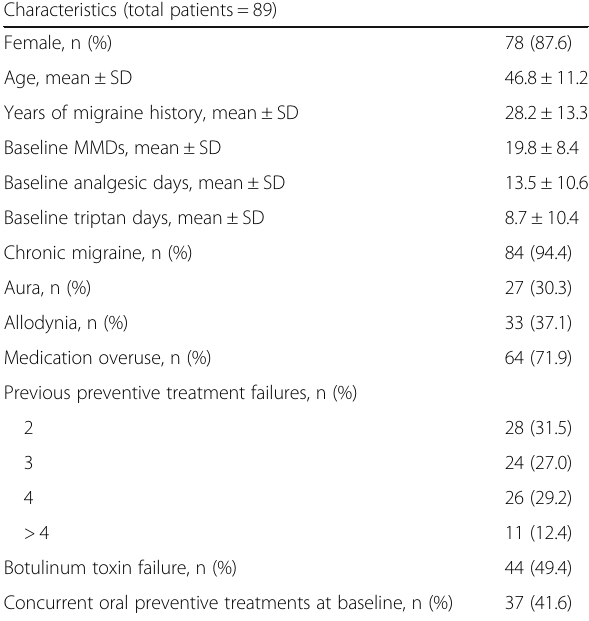
Table 1 Characteristics of the study